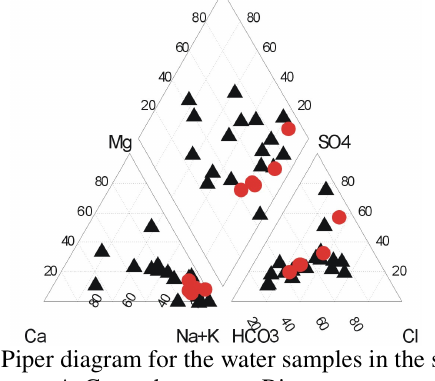
Figure 5. Piper diagram for the water samples in the study area ▲ Groundwater ● River